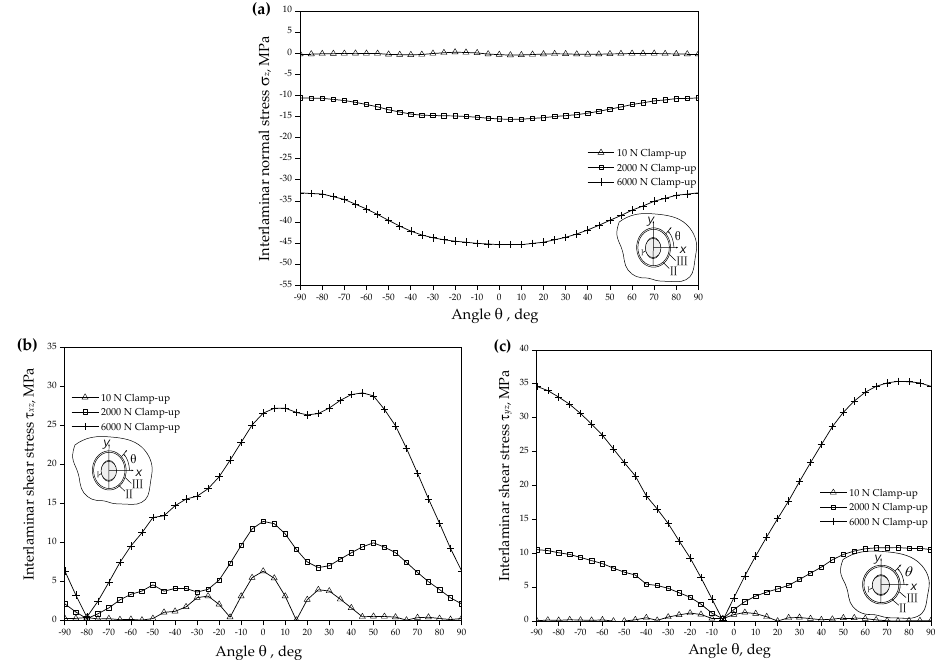
Figure 10. Stress distributions in the 0/45 interface at Position III at different clamping force: ( a ) σ z ; ( b ) τ xz ; ( c ) τ yz